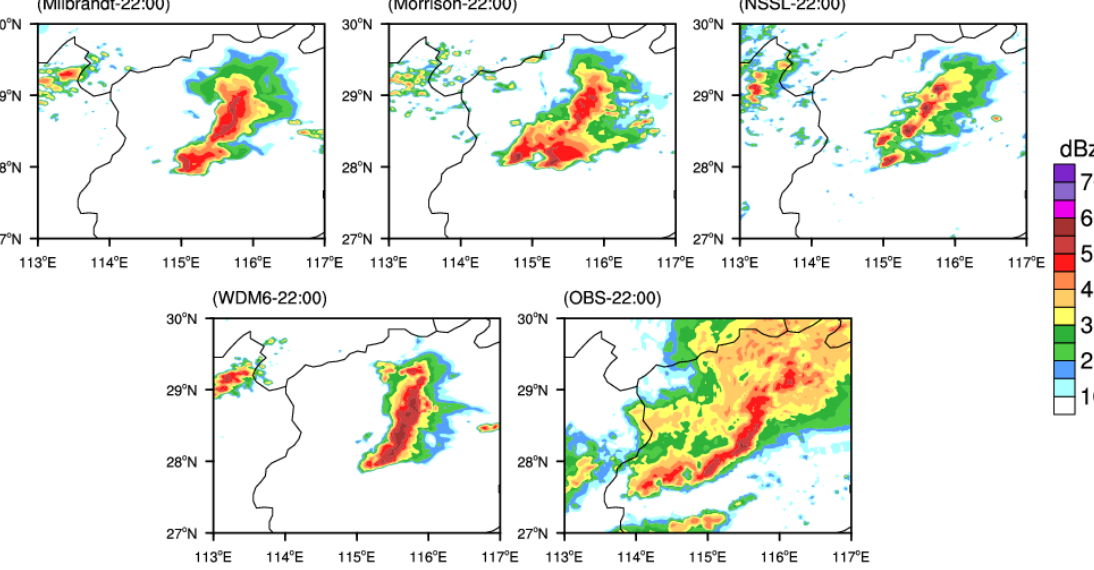
Figure 9. Same as Figure 7 but at 2230 UTC. The blue line is the section position mentioned later. Figure 10 shows the vertical cross section of the simulated and observed radar reflec- tivity across the blue line in Figure 9 at 2230 UTC 15 April 2016. The observed radar re- flectivity top height is about 400 hPa, the largest radar reflectivity is up to more than 50 dBz, and the stratiform area is wide. The WDM6 simulates the structure of the strong convective area well, and reproduces the top height and strength of the strong convective area. But the simulated convective area is wider, and the range of the stratiform area is much smaller. The Morrison, and Milbrandt schemes also simulate strong convective ar- eas, but the strength of the convective areas is weaker, and also no obvious stratiform area appears. The NSSL scheme does not generate a strong convective area with radar reflec- tivity larger than 35 dBz, and the simulation result is worst. In conclusion, compared with the other three schemes, the location and intensity of the strong convective area simulated by the WDM6 scheme are most consistent with observations.